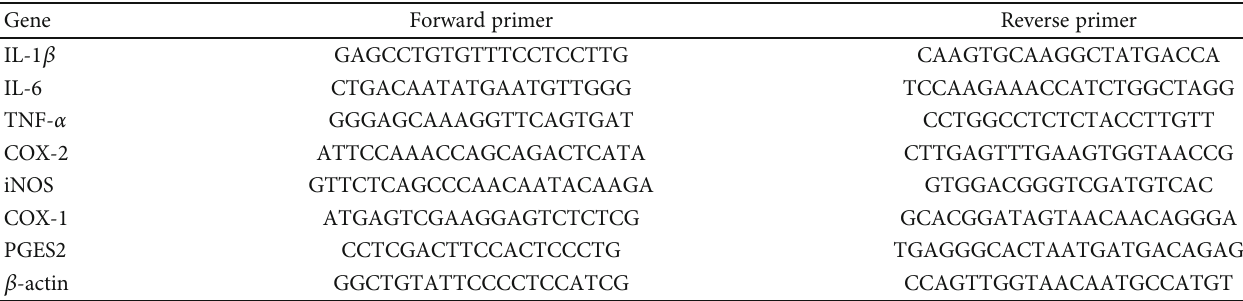
Table 1: Primers used in Real-Time PCR.